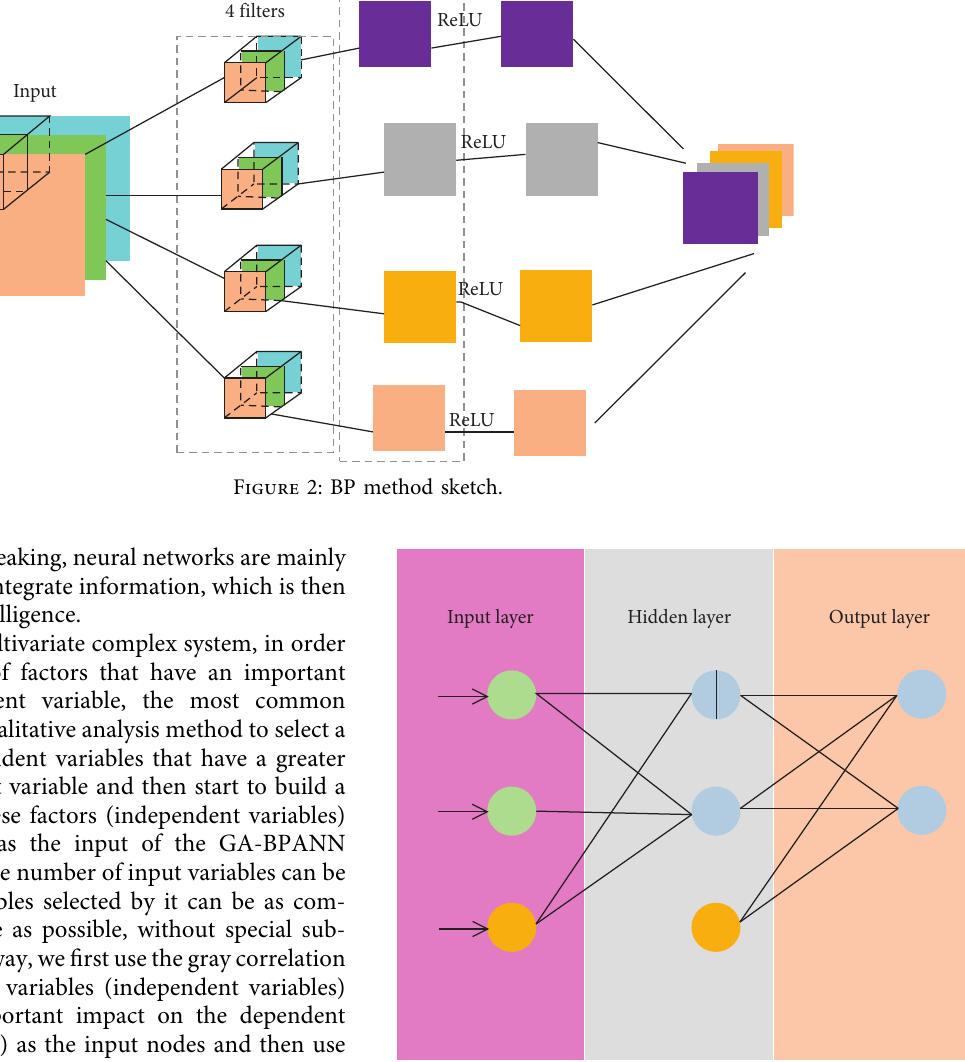
Figure 3: Reverse neural network.